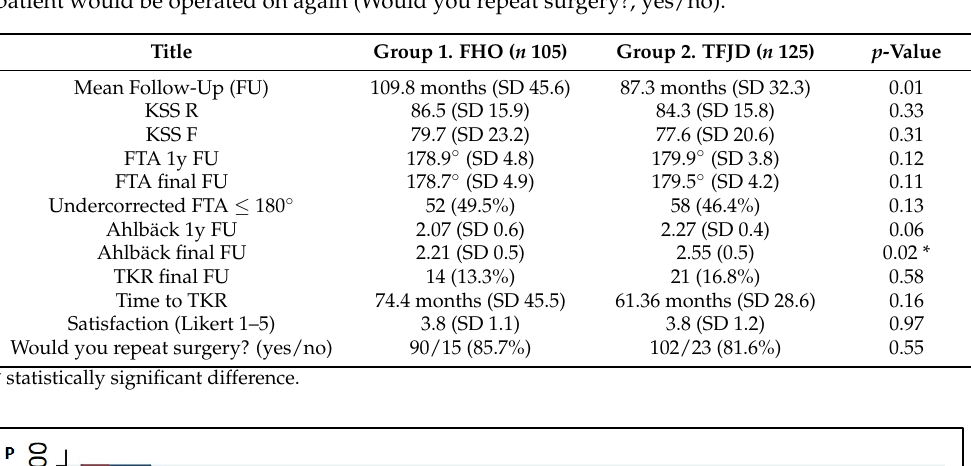
Table 3. Results summary in function of the FHO or TFJD group: clinical results (KSS R and KSS